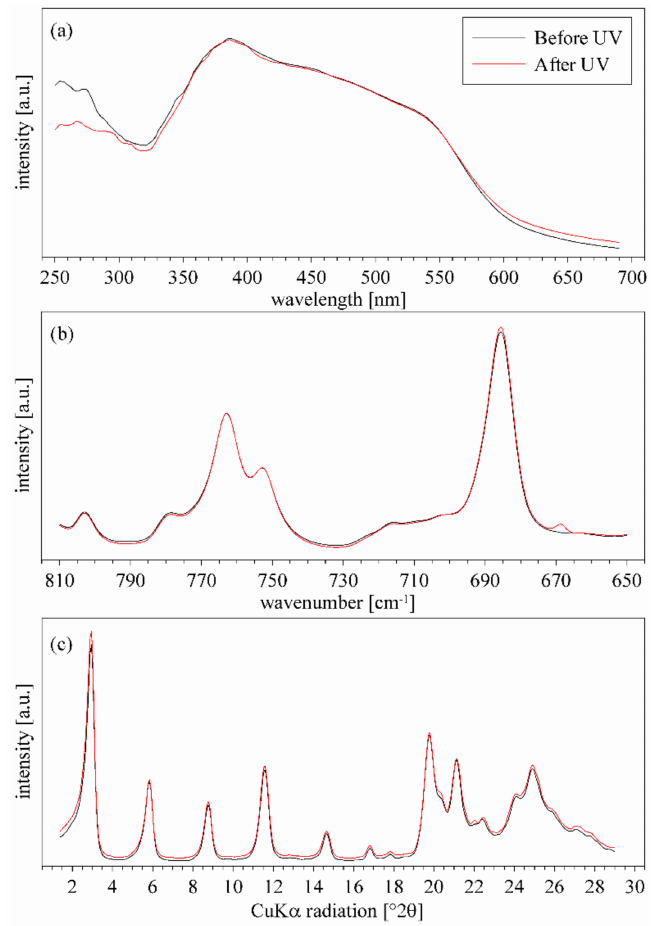
Figure 11. E ff ect of UV irradiation on the ( a ) UV–Vis spectra, ( b ) FTIR spectra, and ( c ) XRD pattern of the ZpA sample.